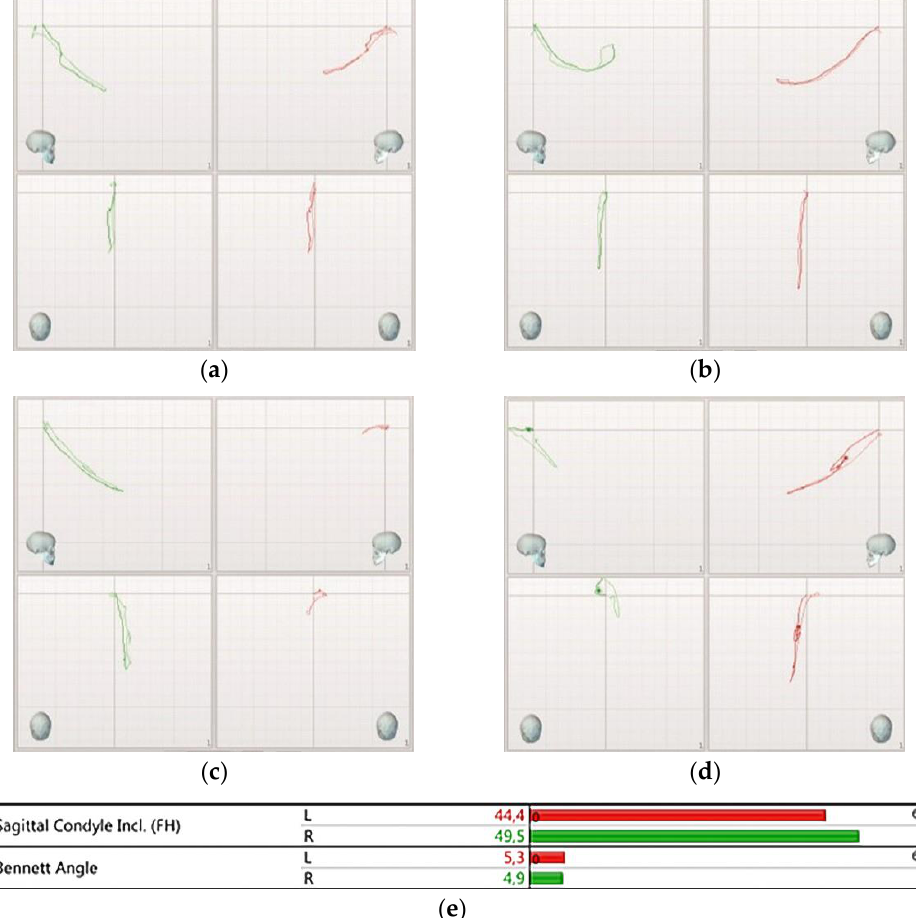
Figure 7. Condylographic recordings after splint therapy: ( a ) protrusion/retrusion tracing; ( b ) open/close of the mouth tracing; ( c ) mediotrusion right tracing; ( d ) mediotrusion left tracing; ( e ) SCI and TCI values of the right (green) and left (red) condyles after splint therapy.